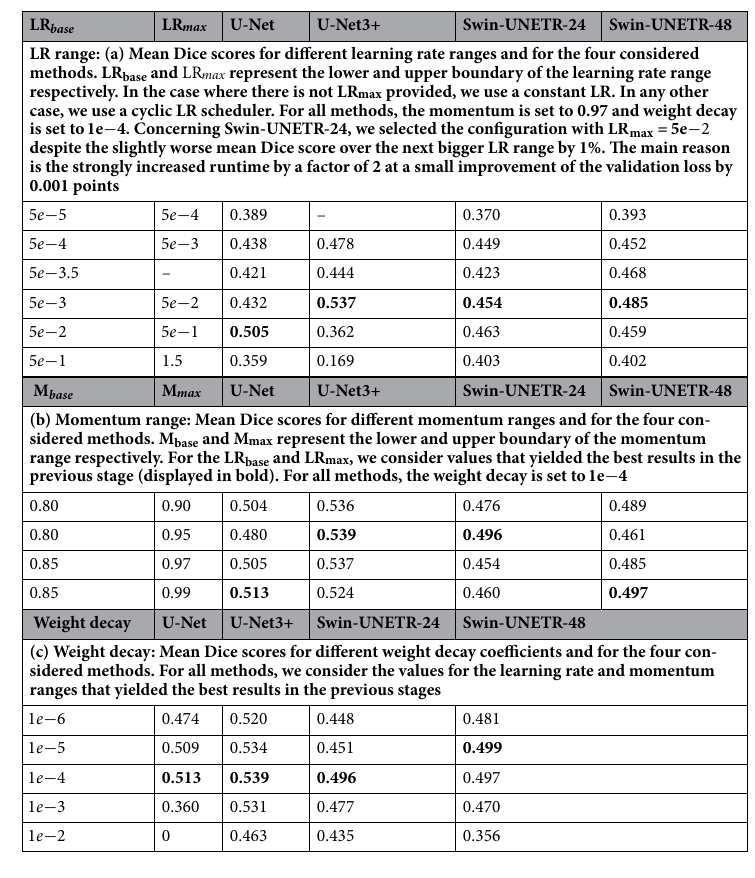
Table 2. Manual search results of optimizer hyper-parameter tuning, performed in 3 consecutive stages. In stage 1 (Tab. a), we find the best values for the learning rate range, in stage 2 (Tab. b) for the momentum range and in stage 3 (Tab. c) for weight decay. The tables show the weighted mean Dice score over the classes of the training epoch calculated on the validation set with the lowest validation loss for the considered hyper- parameter configurations. The best configuration for each method is displayed in